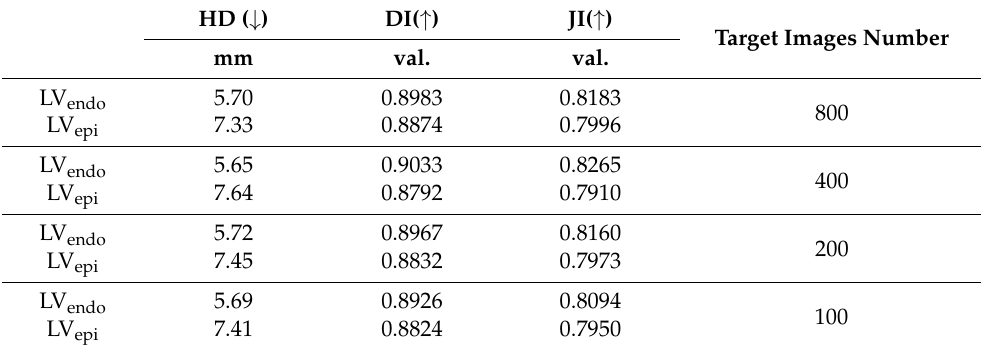
Table 2. Comparison of our MACS model trained with different numbers of target domain images. The up arrow indicates expecting a higher